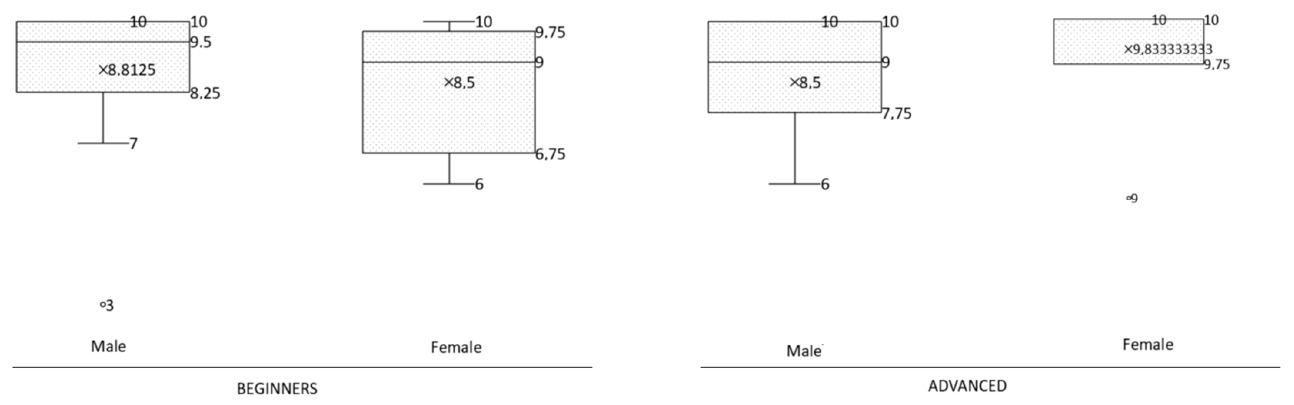
Figure 7. Average of the results by gender of the control group (CG).